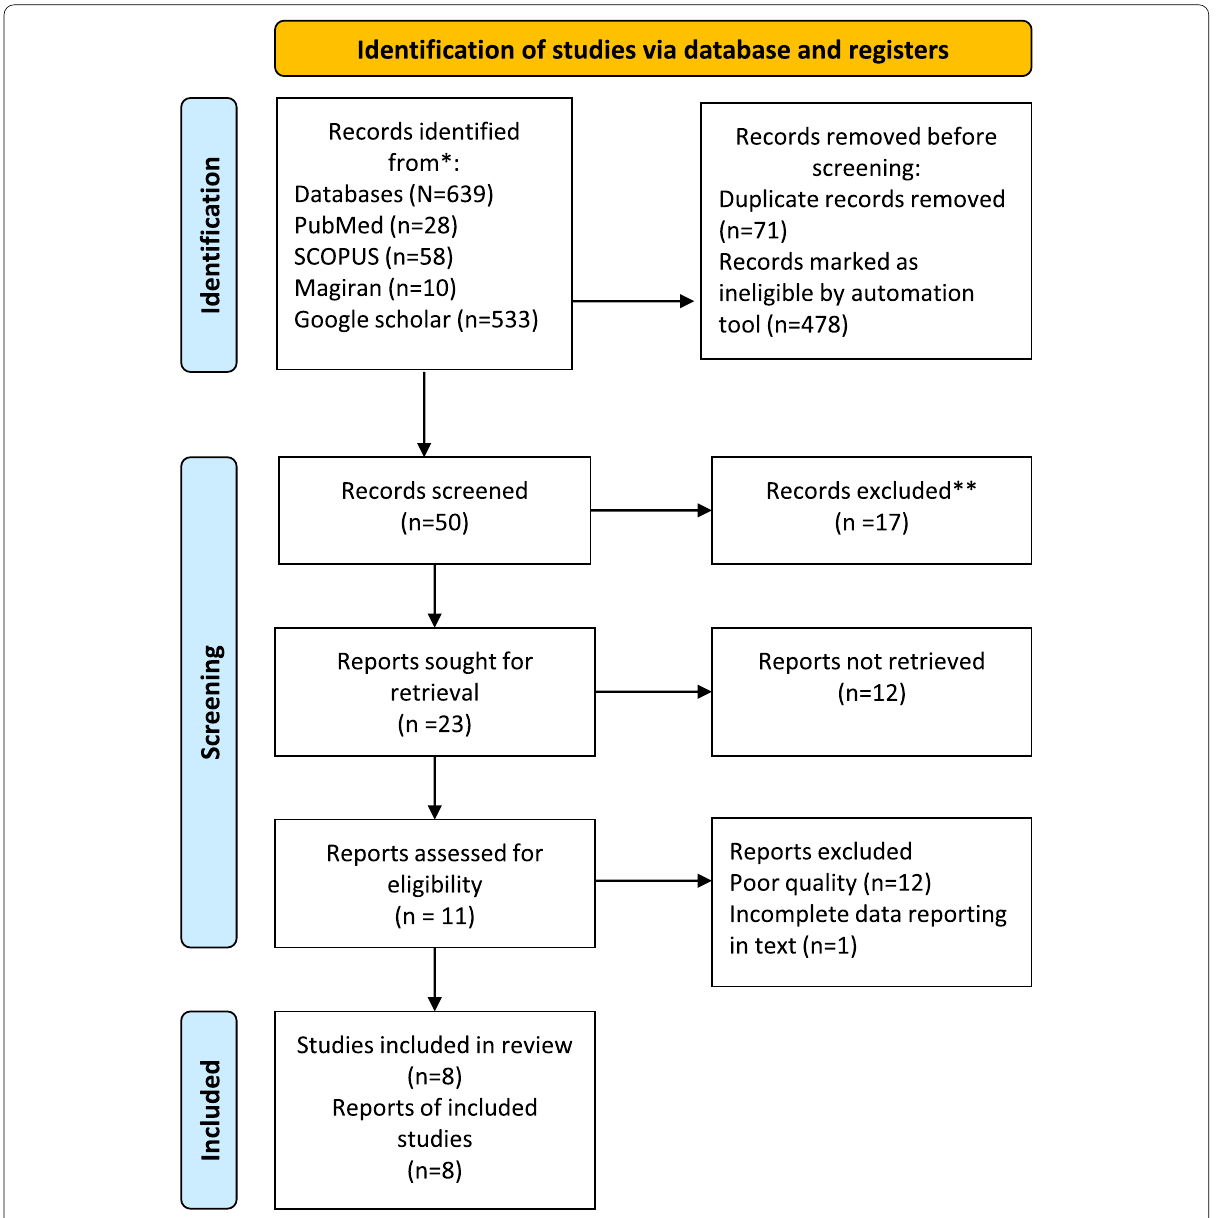
Fig. 1 Successive steps in the selection of studies—PRISMA flow